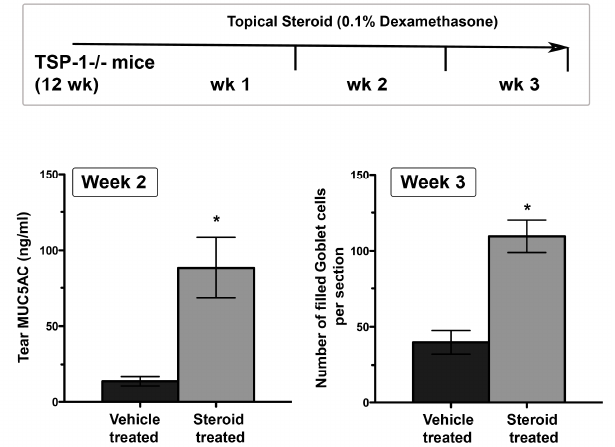
Figure 4. Tear MUC5AC level is a potentially sensitive indicator of anti-inflammatory e ffi cacy of steroids relative to goblet cell density. In experiments that involved topical treatment of 12-week-old TSP-1 − / − mice with 0.1% dexamethasone or vehicle (once per day) for a period of three weeks, tear MUC5AC levels recovered earlier than goblet cell density. ( n = 5 per group, * p < 0.05).